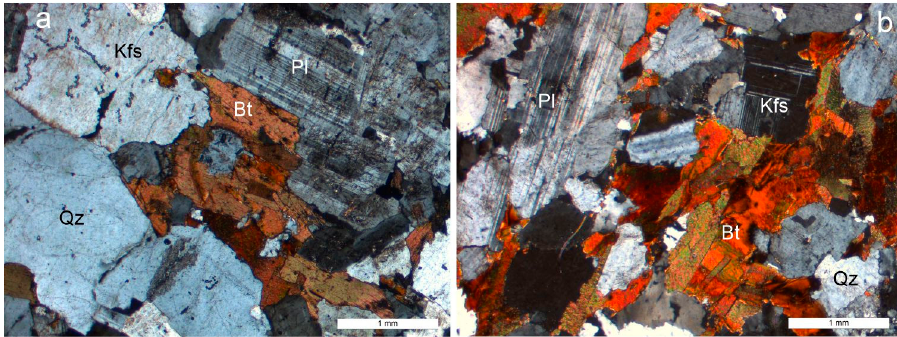
Figure 3. Microphotographs of the Blatná ( a ) and the Č ervená granodiorites ( b ) (Bt—biotite, Kfs—K- feldspar, Pl—plagioclase, and Qz—quartz). Crossed polarizers. Kfs—K-feldspar, Pl—plagioclase, and Qz—quartz). Crossed